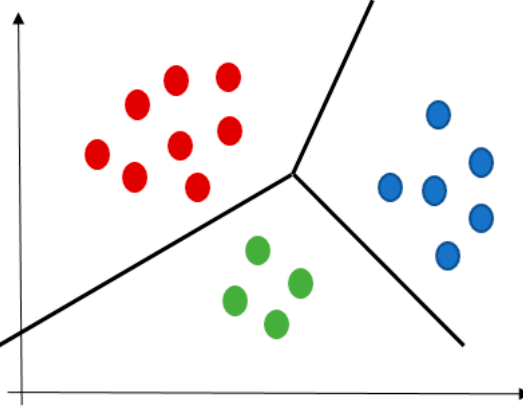
Figure 4. An example of clustering result, individual colors represent different clusters.